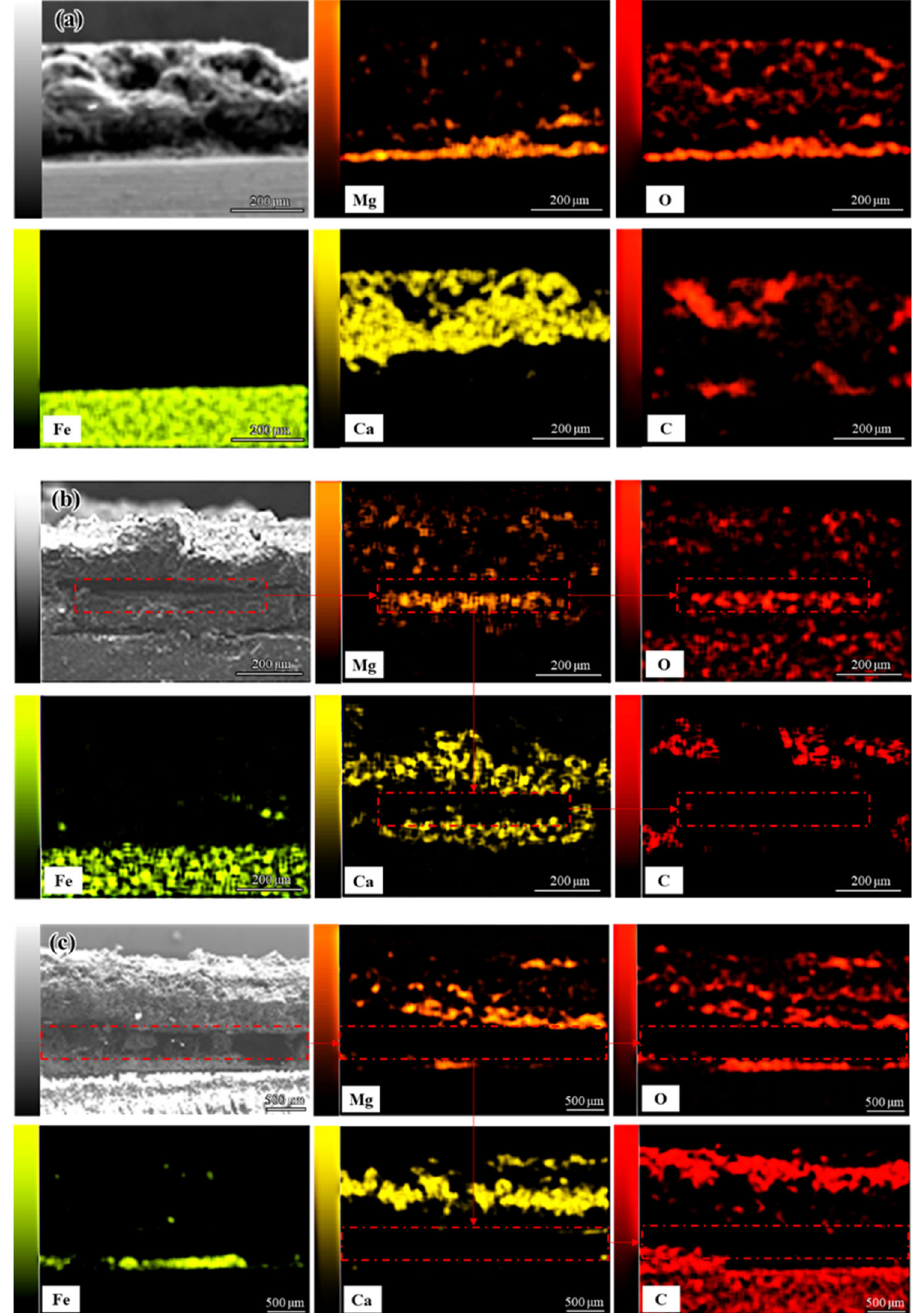
Fig. 12 SEM and EDS. Scanning electron microscopy images and energy dispersive X-ray spectroscopy maps of the deposited layer interface at different tide levels: a full immersion zone, b mid-tide zone, and c high-tide